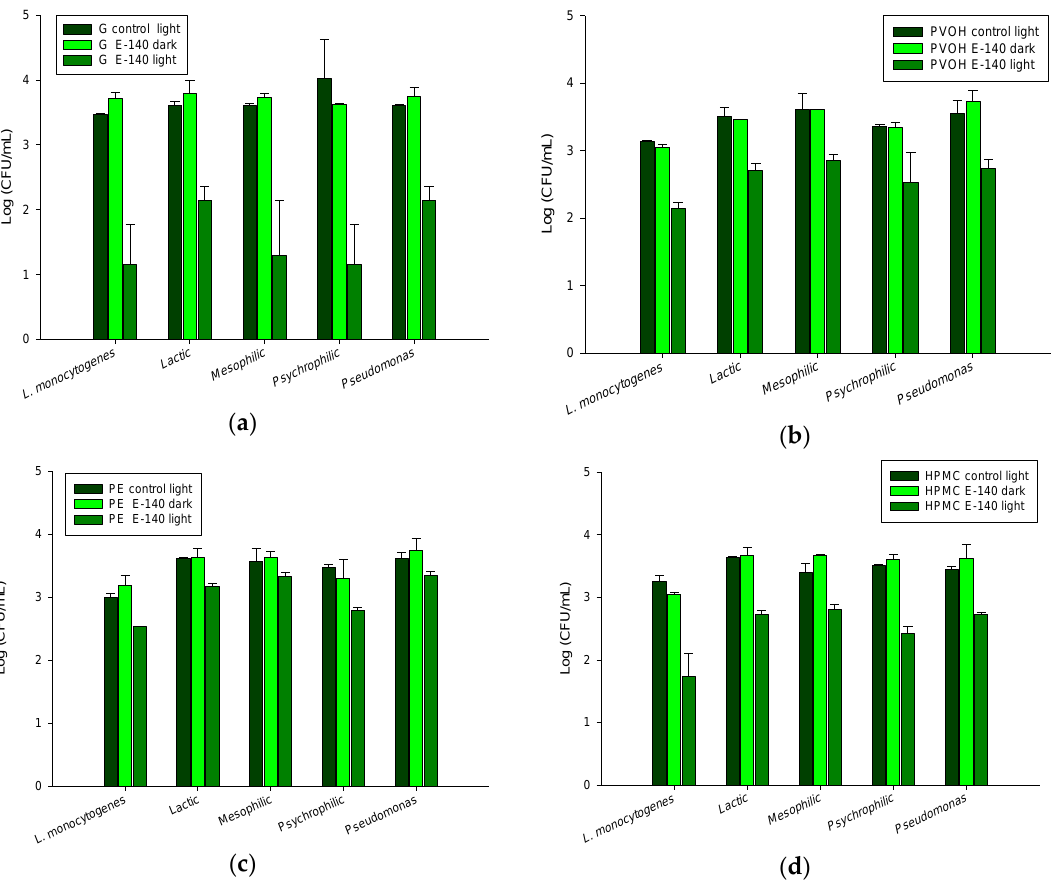
Figure 5. Antimicrobial activity of ( a ) G, ( b ) PVOH, ( c ) PE, and ( d ) HPMC coatings on PET films applied to bologna slices.